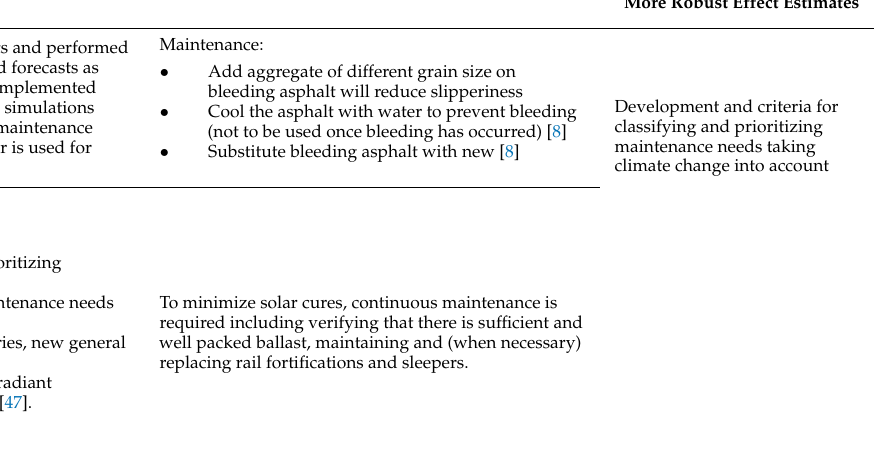
Table 1. Climate-change related weather events and potential consequences considered, potential risk reduction measures and methods, data and investigations identified to be applied for the risk and effect assessments. Methods and Data Required for Ex-Ante Assessment of Potential Consequences 3 Potential Risk Reduction Measures (Figure 1)